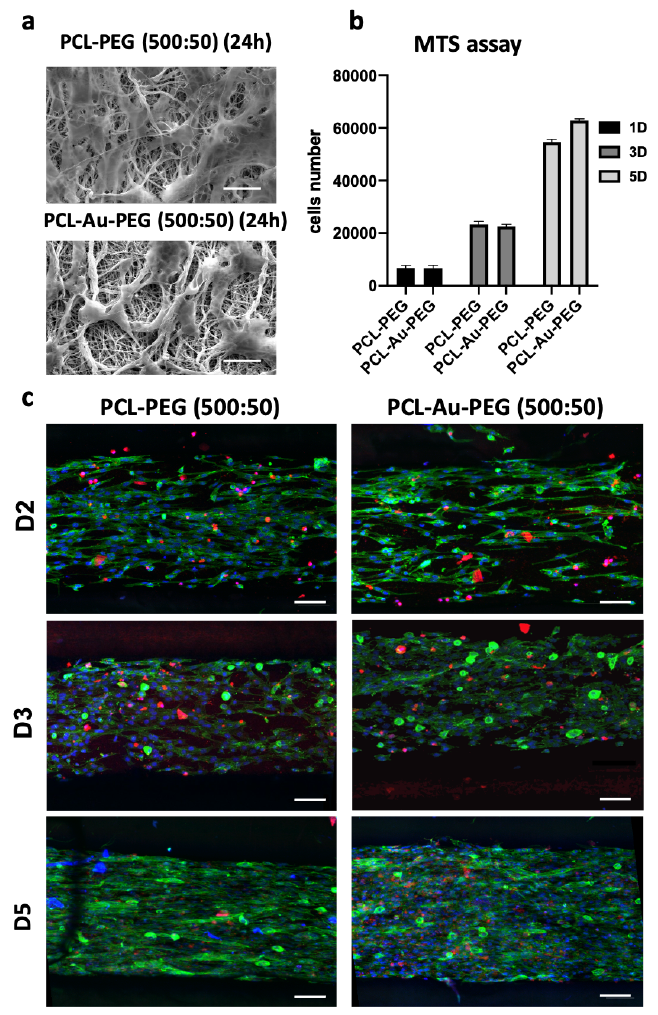
Figure 6. Cell adhesion and proliferation on the scaffolds. ( a ) MEB images of C2C12 myoblasts adherent to the scaffolds with micropatterned (500:50) coated or not with gold nanoparticles, 24 h after cell seeding. Scale bar 20 µm. ( b ) MTS assay illustrating cell proliferation was followed on PCL-PEG (500:50) and PCL-Au-PEG (500:50) at D1, D3, and D5 ( n = 6); ( c ) the viability was observed on those scaffolds by confocal images with dead cells emitting in red fluorescence (Far Red), nuclei in blue fluorescence (Hoechst-33258) and F-actin in green fluorescence at 2, 3, and 5 days. Scale bar represents 100 µm. (The data obtained for MTS were compared with the Mann–Whitney nonparametric statistical test: there was no statistical difference between the conditions PCL-PEG (500:50) and PCL-Au-PEG